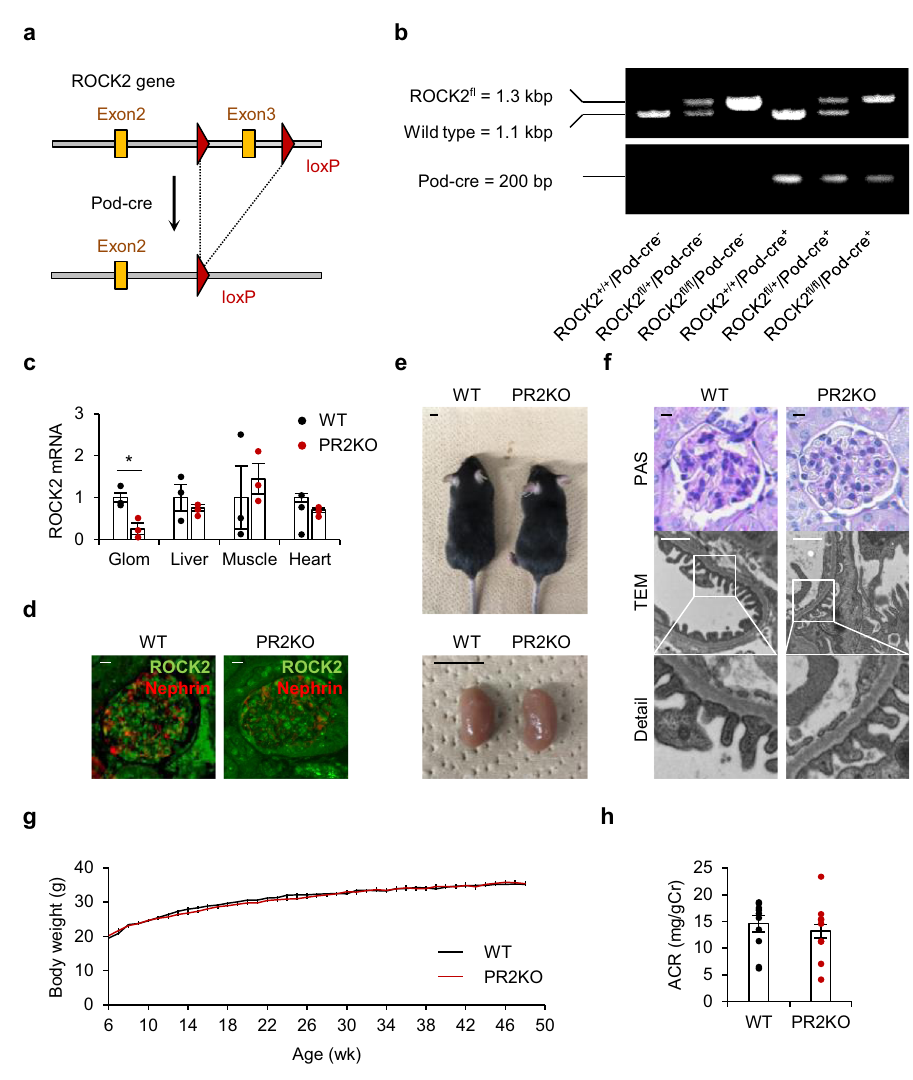
Fig. 2 Generation of podocyte-speci fi c ROCK2-de fi cient mice. a The strategy for the generation of podocyte-speci fi c ROCK2 knockout mice. Gene- targeting vectors were constructed to delete exon 3 of ROCK2. b Representative genotyping PCR detecting transgenic ROCK2- fl oxed alleles and Podocin- Cre (Pod-Cre). c Con fi rmation of tissue-restricted-ROCK2 deletion in podocyte-speci fi c ROCK2 knockout mice (PR2KO). The mRNA levels of ROCK2 in the glomerulus (Glom), liver, muscle, and heart are demonstrated ( n = 3). d Immunolabeling of ROCK2 and the expression of nephrin in kidney sections obtained from WT and PR2KO mice. The scale bar at the left top represents 10 μ m. e Representative images of the whole body (upper panel) and kidney (lower panel) in each genotype. The scale bar on the top left represents 1 cm. f Representative PAS staining and transmission electron microscope (TEM) images of the glomerulus from WT and PR2KO mice. The scale bars at the top represents 10 μ m and 1 μ m, respectively. g Body weight information in aged WT and PR2KO ( n = 9 – 11). h ACR at 12 months of age ( n = 9 – 10). * p < 0.05. Data represent the mean ±